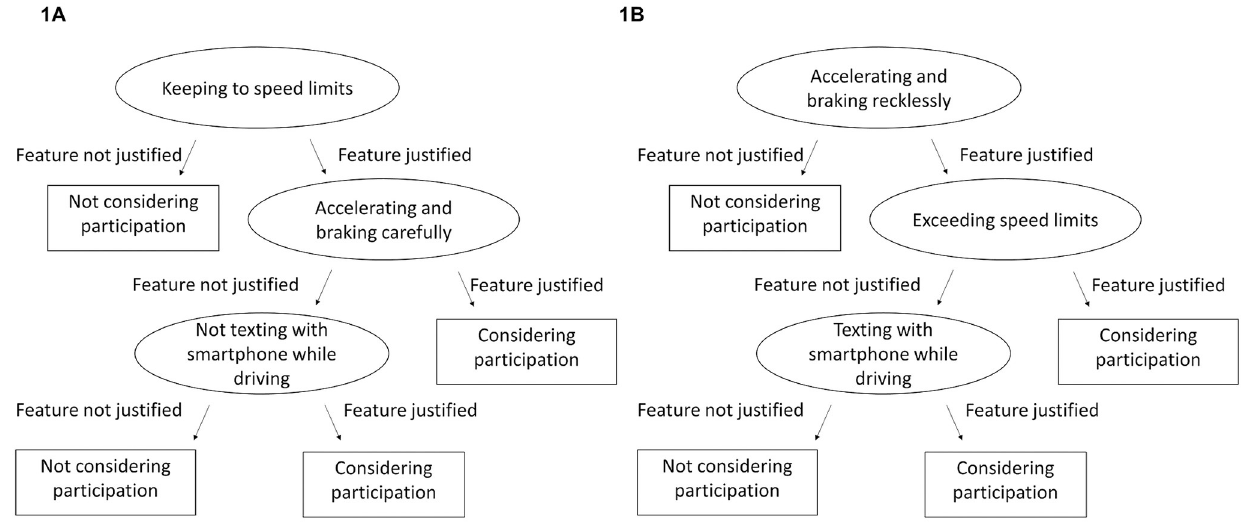
Fig 1. Fast-and-frugal decision trees (FFTs) for driver scoring with bonus (A) and malus framing (B).